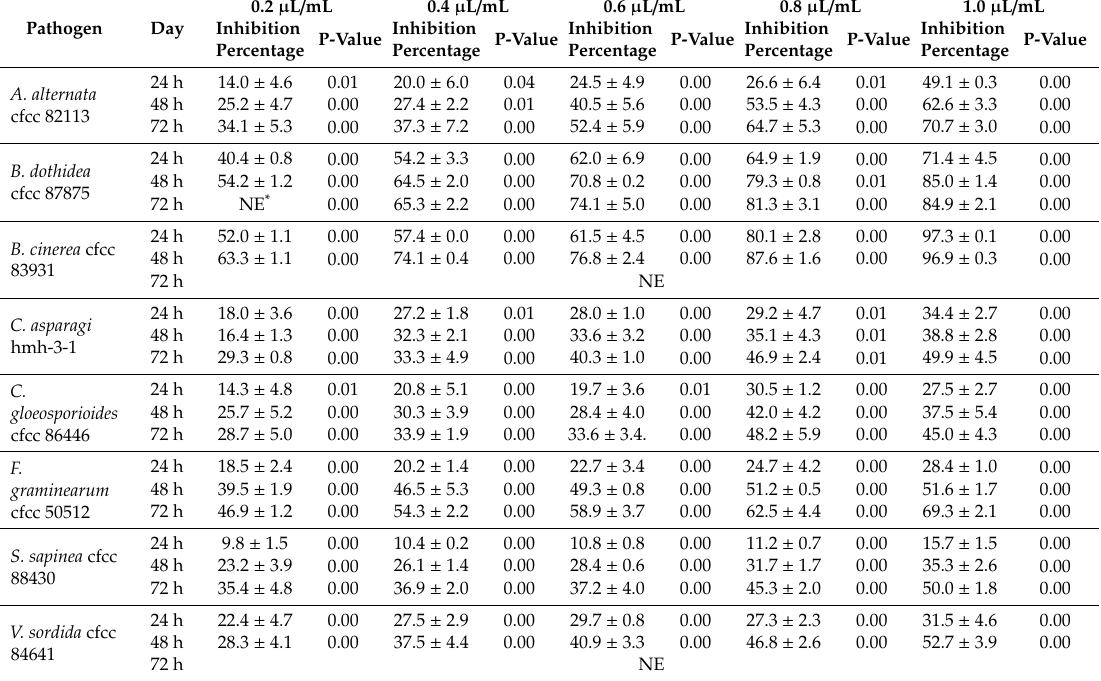
Table 5. E ff ects of (-)-4-terpineol on fungal pathogens of plants determined by two-compartment Petri plate bioassay method.